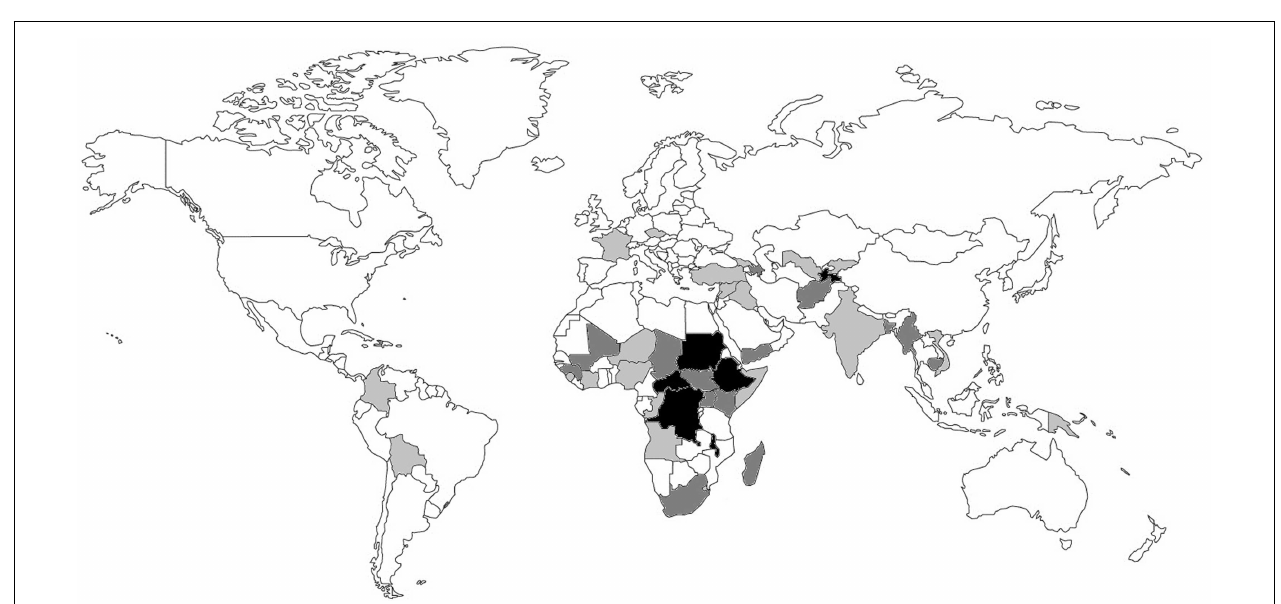
FIGURE 3 | Country of origin of the telemedicine cases ( n = 1039) .The countries are shaded: light gray, < 5 cases; dark gray, 5–50 cases; black, > 50 cases. The country of origin could not be determined in a small proportion of cases (1.2%).